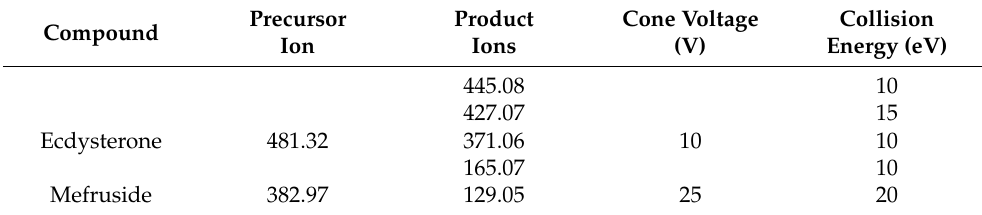
Table 2. MRMs of ecdysterone and internal standard.